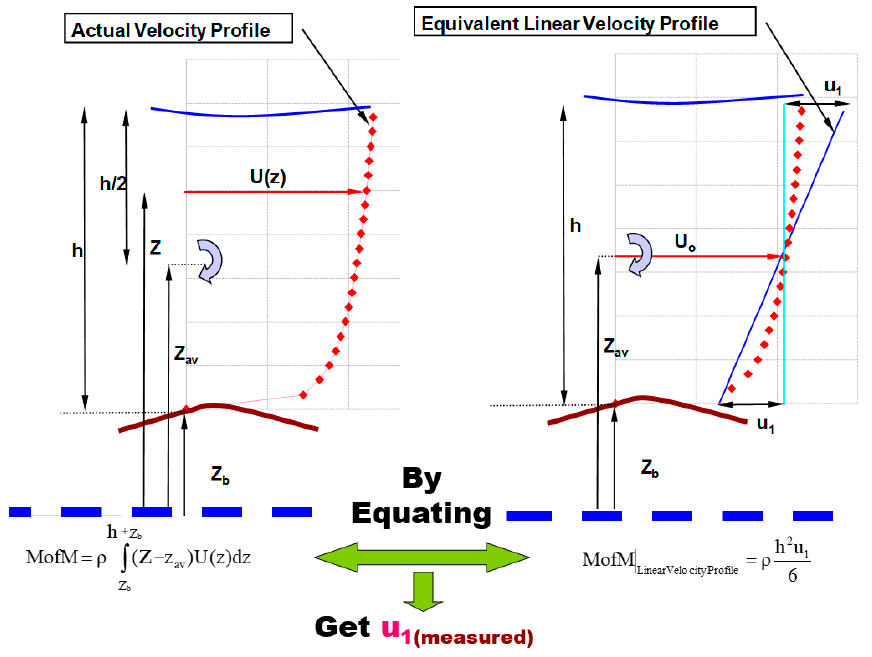
Figure 1. Definition of Moment Velocity Scale 𝑢 (cid:2869)